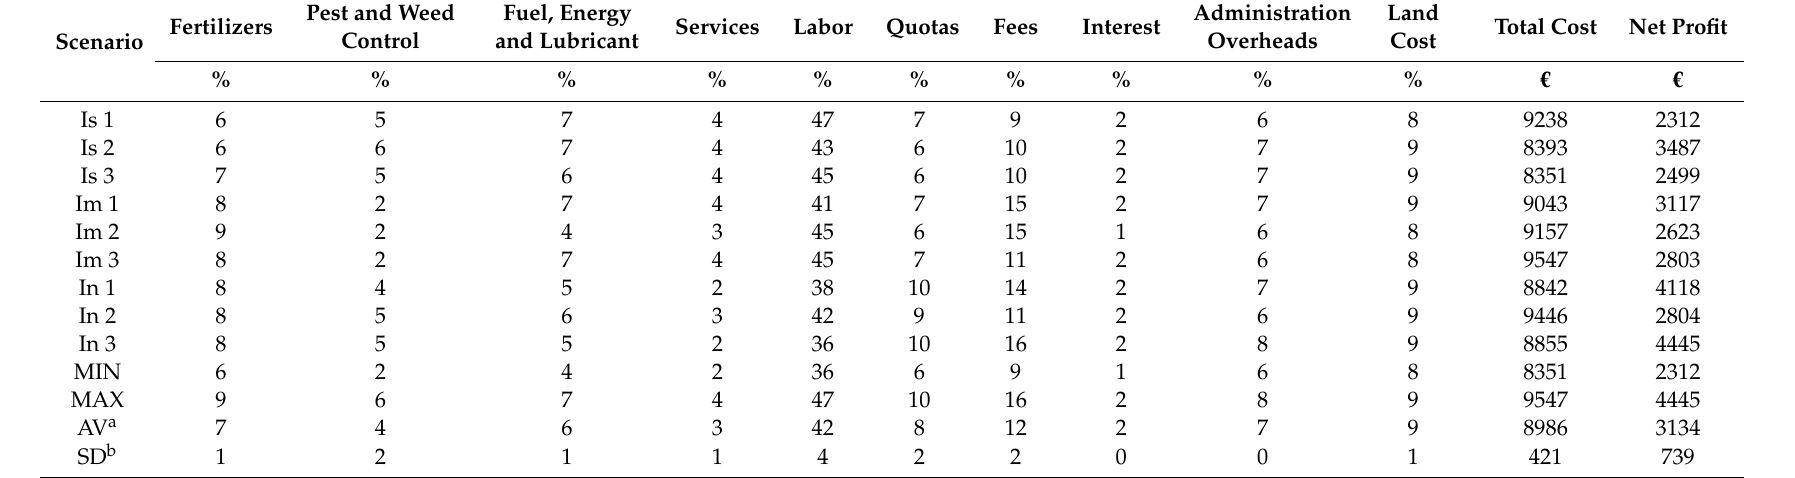
Table 7. Economic results in the integrated farming system (ha − 1 year − 1 ).